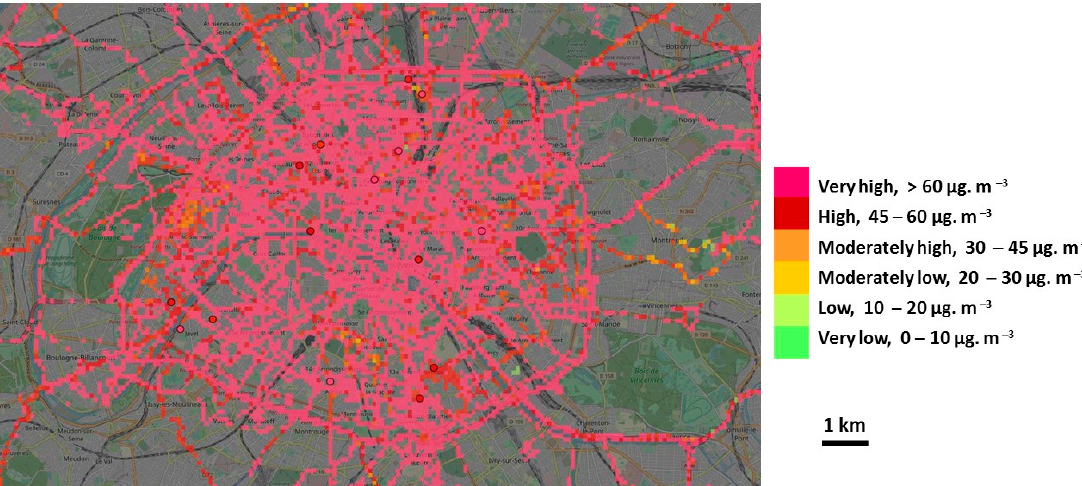
Figure 16. Pollution map in Paris averaged for the 25–27 November 2020. North is up.